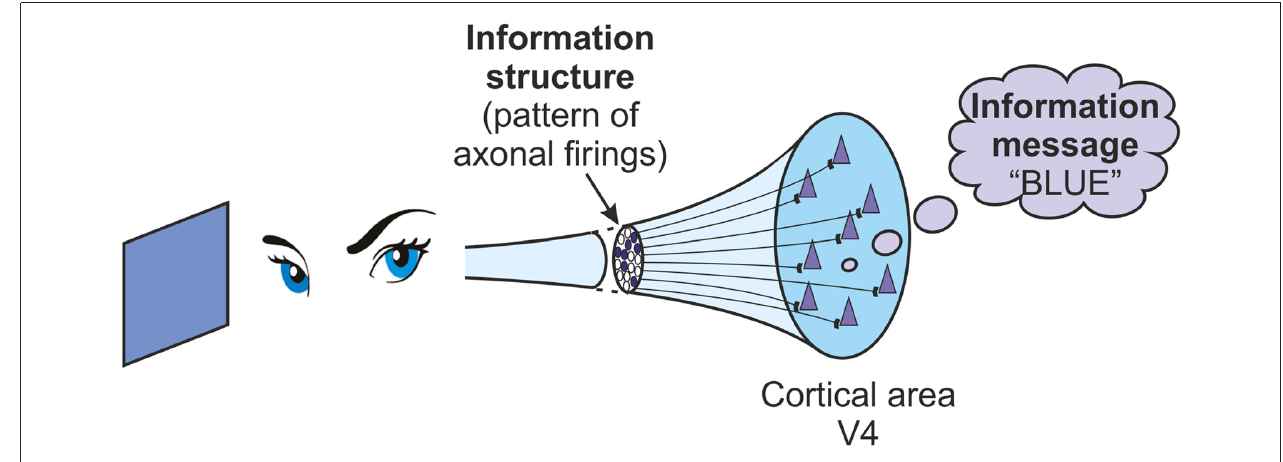
FIGURE 1 | A brain attending to the color blue receives a pattern of inputs to the V4 area of its visual cortex. This pattern is an information structure. Its meaning to the brain, “blue”, is an information message.